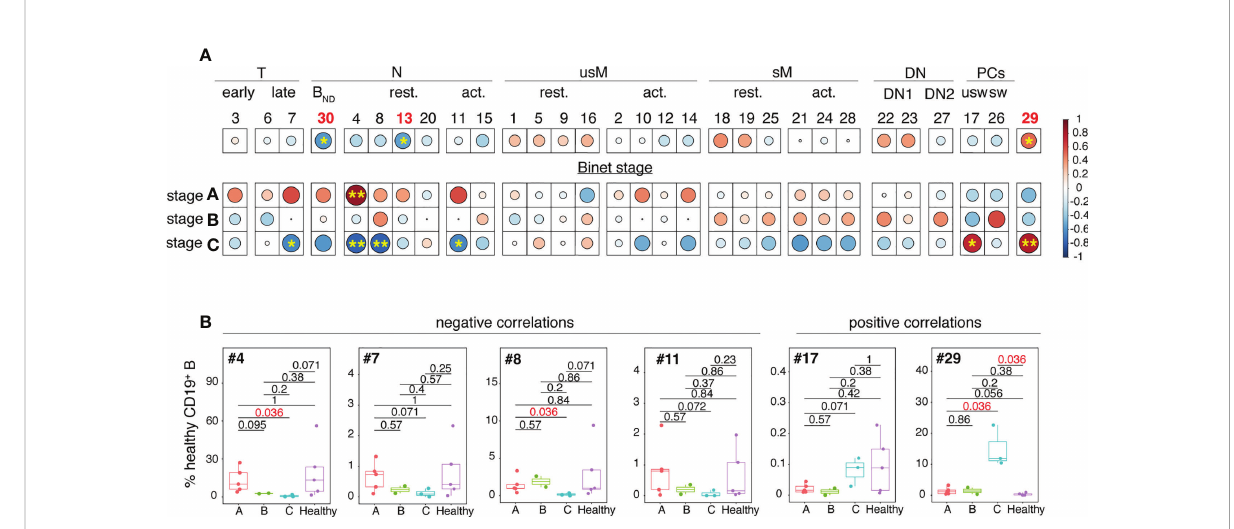
FIGURE 4 Analysis of the inter-relationships between non-malignant B cell cluster frequency and Binet stages. (A) Clusters have been organized and grouped according to the B cell developmental stage they belong to. The color of the circles corresponds to the correlation (red for positive, blue for negative) and the stars and size of the circles indicate the degree of signi fi cance of the correlation (*p < 0.05, **p < 0.01). (B) Box and whisker plots illustrating the frequencies of the clusters which abundance is correlated with Binet stage C in stage A, B and C patients. Statistical signi fi cancy was estimated with the Mann-Whitney U test. The p values are indicated on the graphs. P values of <0.05 were considered as statistically signi fi cant and are identi fi ed in